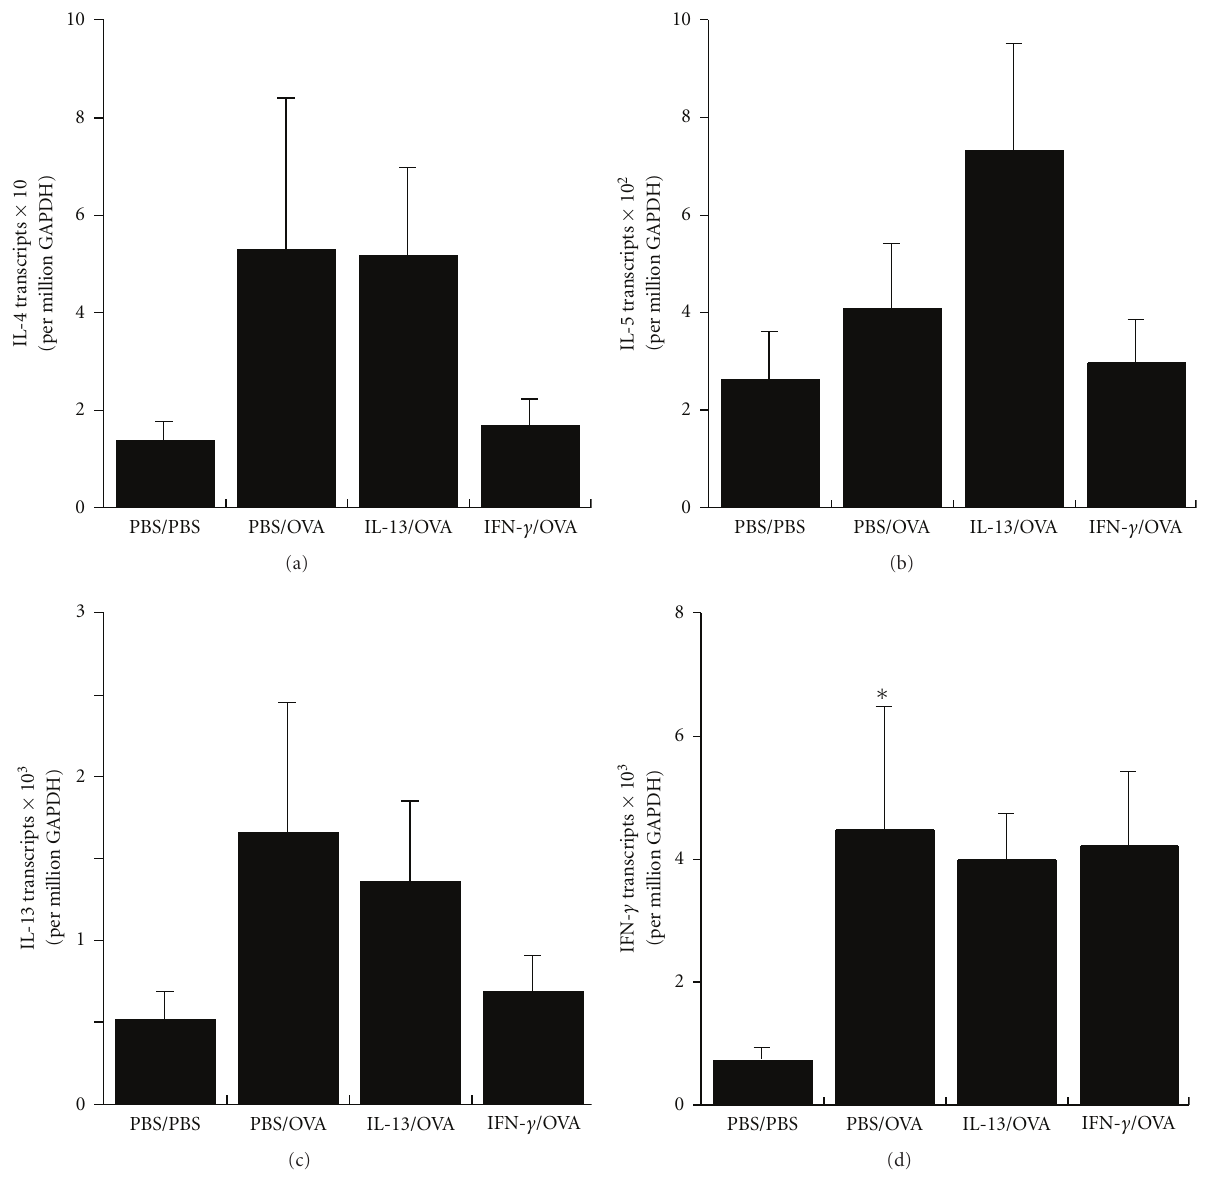
Figure 5: E ff ects of IL-13 and IFN- γ on Th1 and Th2 cytokine transcripts. Levels of IL-4 (a), IL-5 (b), IL-13 (c) and IFN- γ (d) whole lung transcripts from PBS/PBS, PBS/OVA, IL-13/OVA and IFN- γ /OVA groups of mice. ∗ P -value ≤ . 05 versus PBS/PBS.